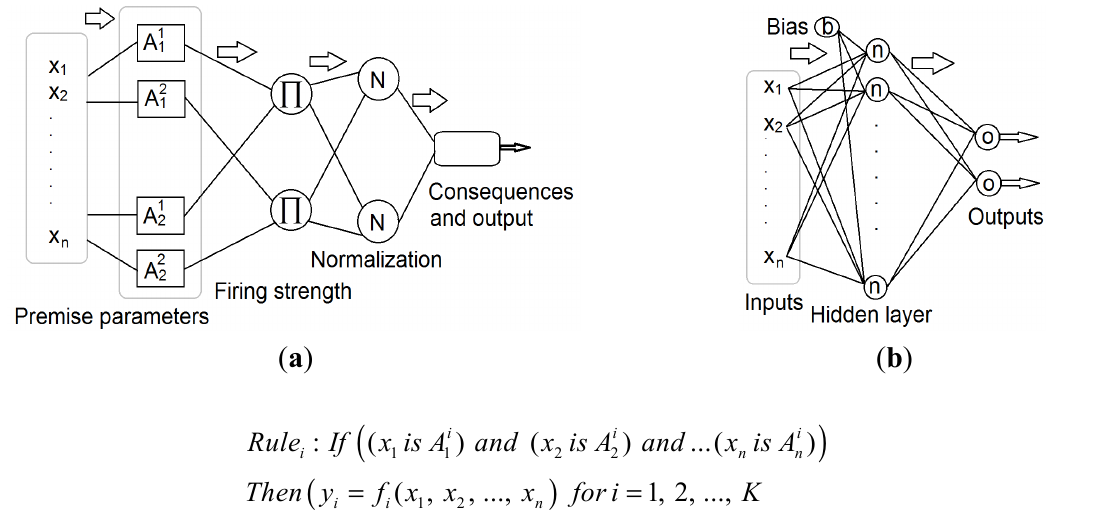
Figure 3. Schematic representation of the ( a ) adaptive neural-based fuzzy inference system; and the ( b ) feed-forward Levenberg-Marquardt artificial neural network